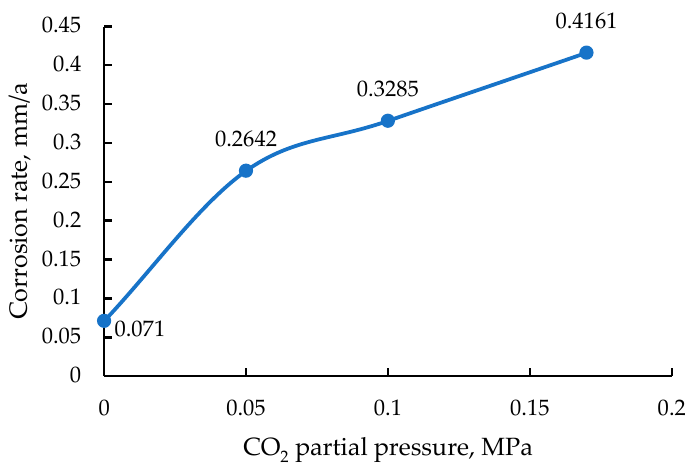
Figure 3. Variation curve of 20# steel dynamic corrosion rate with CO 2 partial pressure.